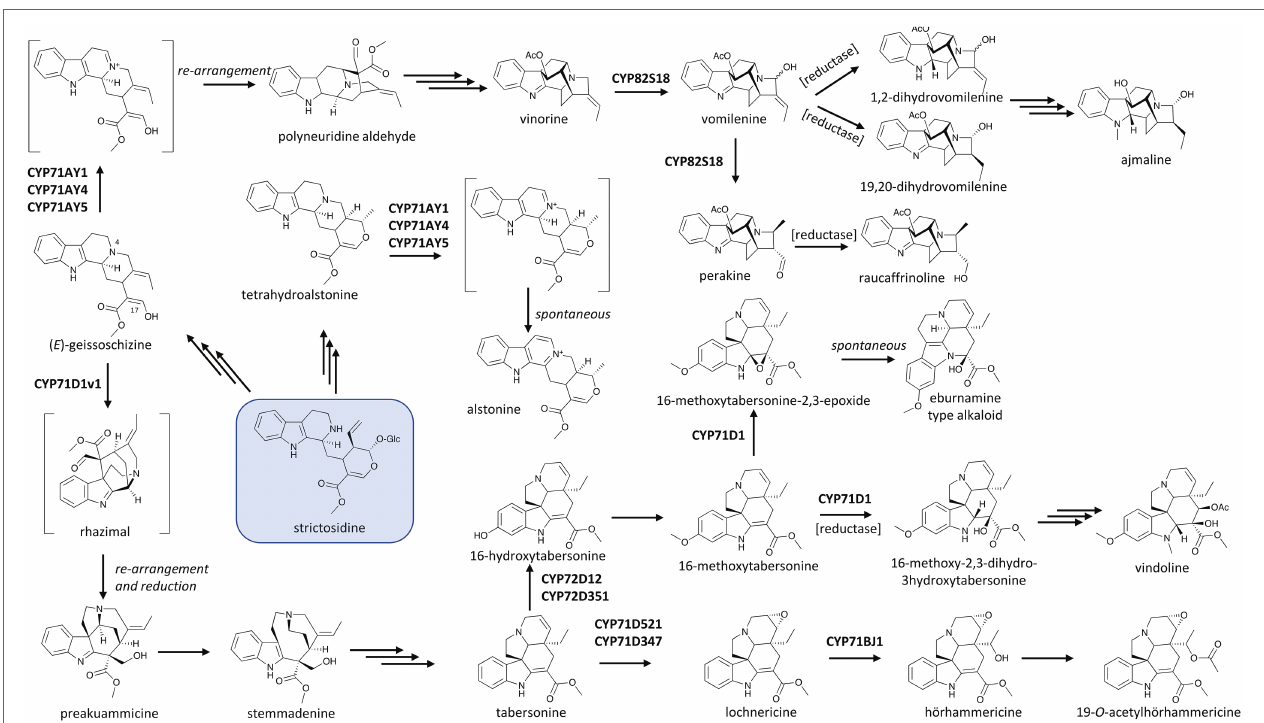
FIGURE 2 | P450s in the biosynthetic network of monoterpenoid indole alkaloids (MIAs) in the Apocynaceae with strictosidine (boxed) as the central precursor. Multiple and single arrows indicate multiple- and single-step pathways, respectively. Enzymes indicated here are discussed in the text. V19H: (+)-vincadifformine 19-hydroxylase, a close homologue of